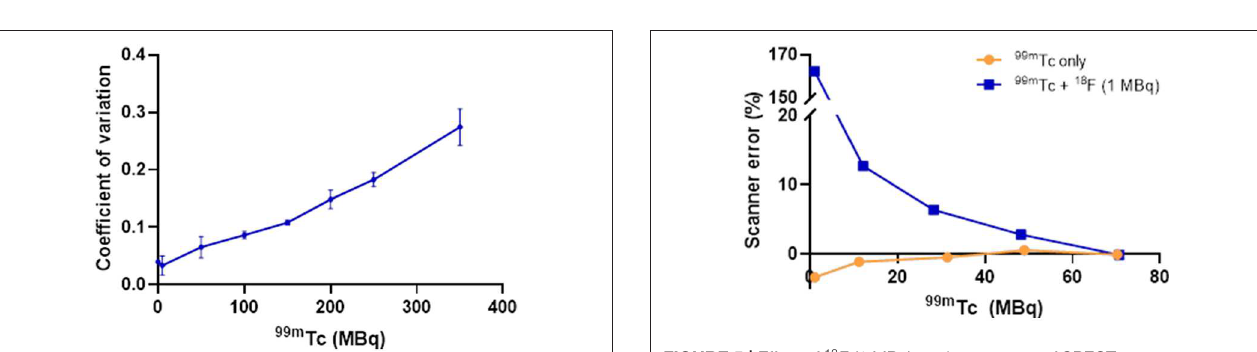
FIGURE 5 | Effect of 18 F (1 MBq) on the accuracy of SPECT scanner quantification of increasing amounts of 99m Tc. The effect on scanner quantification was assessed by comparing the amount of 99m Tc measured by the dose calibrator to that measured by the SPECT